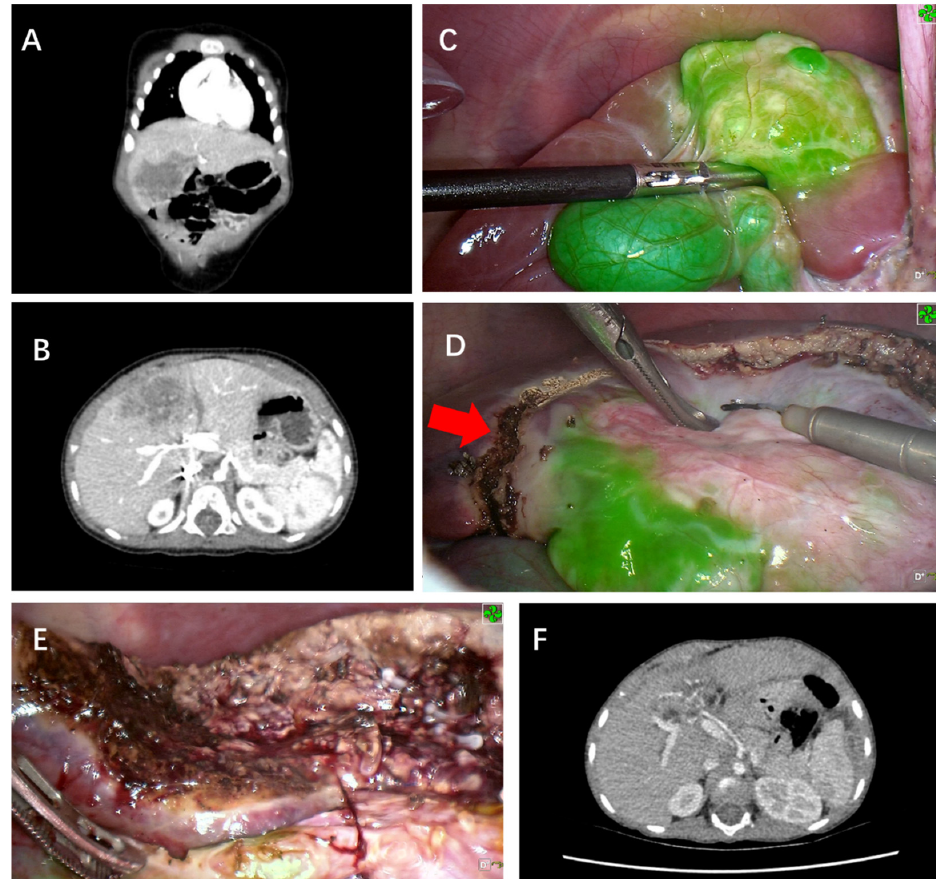
Figure 1. ICG fluorescence-guided laparoscopic hepatectomy of Segment 4a (case no. 5 in Table 1). ( A ) Preoperative coronary CT examination of tumor. ( B ) Preoperative cross-sectional CT examination to measure the size of the mass. ( C ) Green fluorescence was observed in the S4 segment of the liver and gallbladder after the fluorescence mode was turned on. ( D ) Before liver removal, a marker line (red arrow) was made on the surface of the liver based on fluorescence imaging ( E ). After complete removal of the tumor, the incision margin was checked and no fluorescence was observed, indicating the complete removal of the tumor without bile leakage. ( F ) No signs of tumor residues or recurrence were observed via CT 12 months after